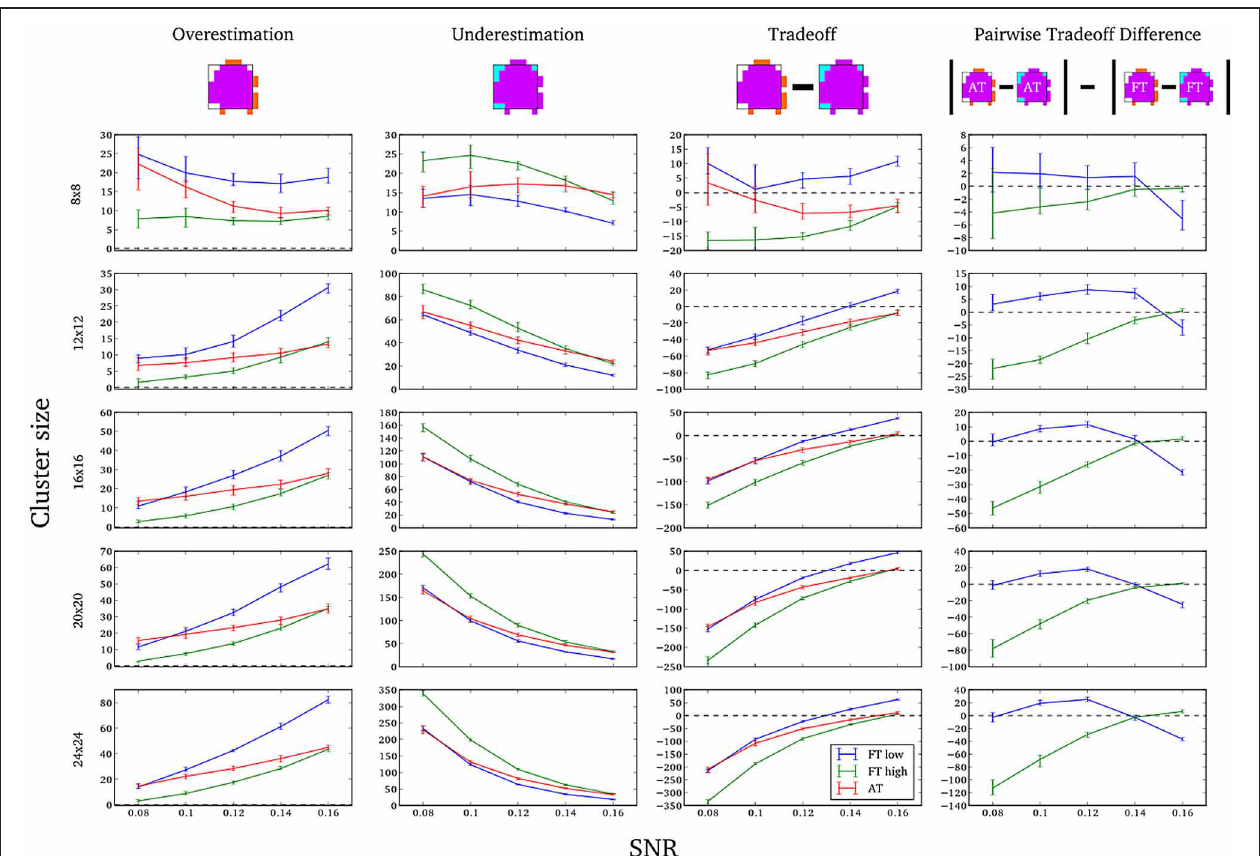
FIGURE A1 | Illustrationofoverand underestimation,and performancesofATandFT withlowclusterformingthresholds. At the top is an illustration of an observed cluster (purple) over the true underlying signal (square outline). Estimated voxels outside of the true border are in orange and missed voxels inside the border are incyan. Below,graphs represent four biases. On the left are displayed the H-D estimates of the median cluster extent overestimation (number of false positive voxels for a particular cluster). Next are displayed the H-D estimates of the median